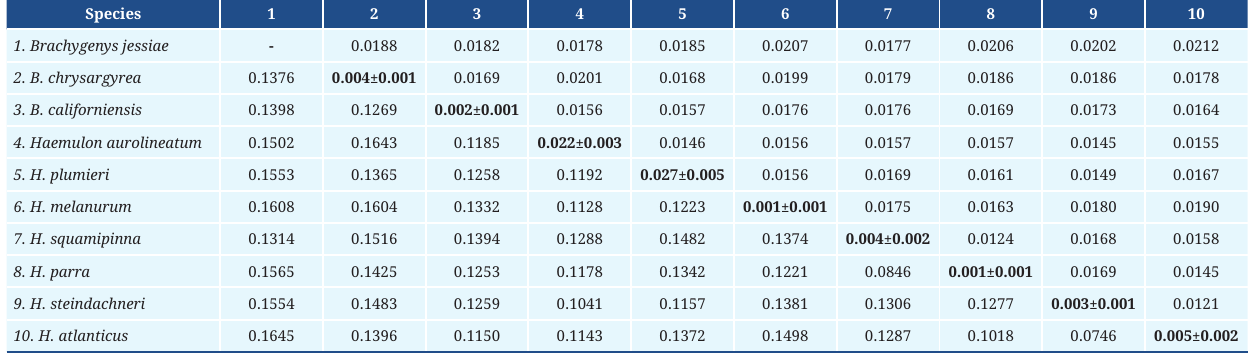
TABLE 1 | Pairwise K2P genetic distances between the Brachygenys and Haemulon species (below the diagonal) and standard errors (above the diagonal). The numbers in bold type represent the intraspecific K2P genetic distances and their standard errors. Species